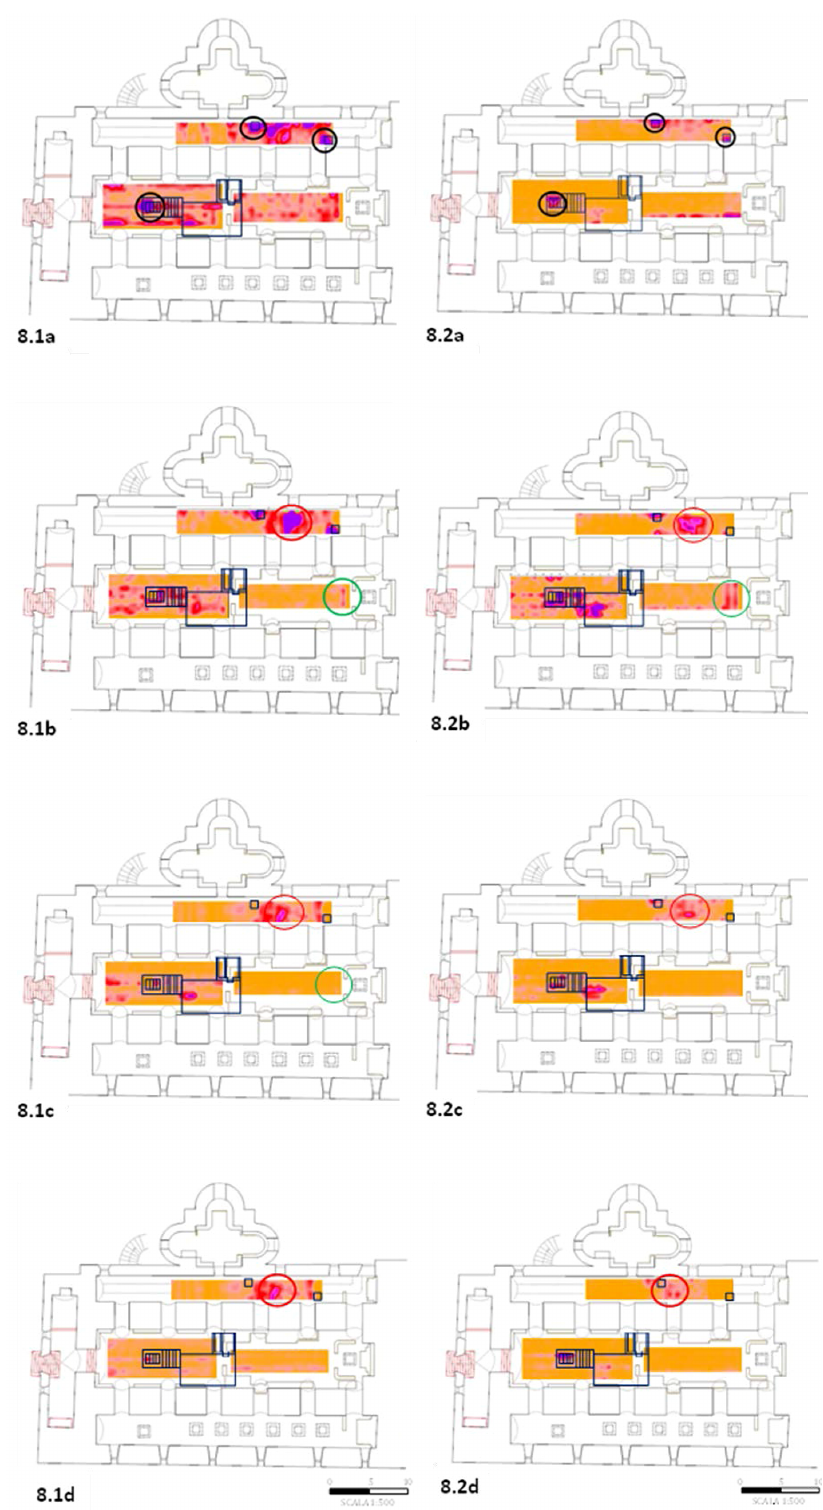
Figure 8. A comparison of the results achieved with the antennae at 600MHz for the pulsed system (Fig. 8.1a–8.1d) and the “medium antennae” for the GPR-R prototype system (Fig.